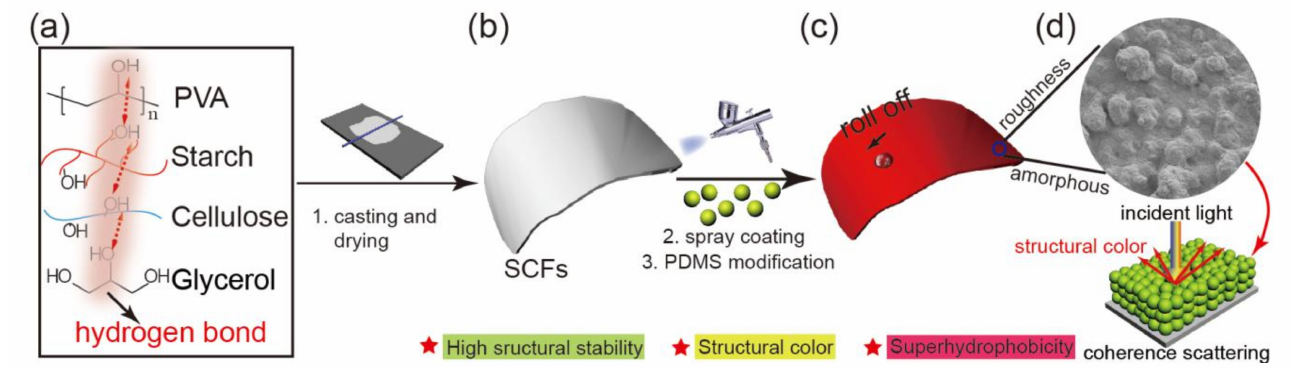
Figure 1. Schematic illustration showing the SPF films’ preparing process and the coloring mech- anism. ( a ) Schematic diagram of intermolecular hydrogen bonding among starch, PVA and fiber in SCFs; ( b ) the SCFs prepared casting and drying; ( c ) the colored SCFs prepared by spraying SiO 2 NPs/Carbon Black on the surface and PDMS modification; ( d ) the micro-morphology of the colored SCFs and the schematic diagram of structural